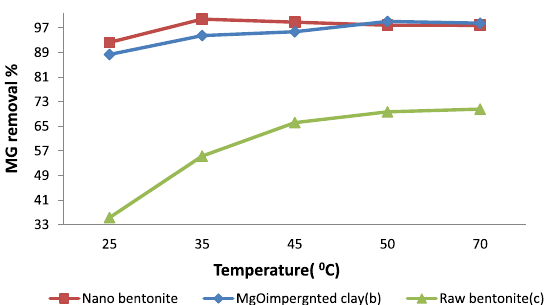
Fig. 8 Effect of contact time on MG dye removal by a nano-bentonite, b MgO impregnated clay and c raw